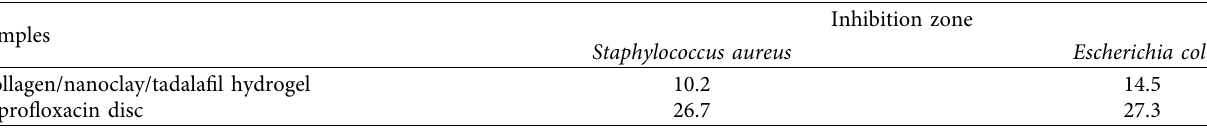
All samples were tested three times in independent experiments ( p < 0 . 05 ) .